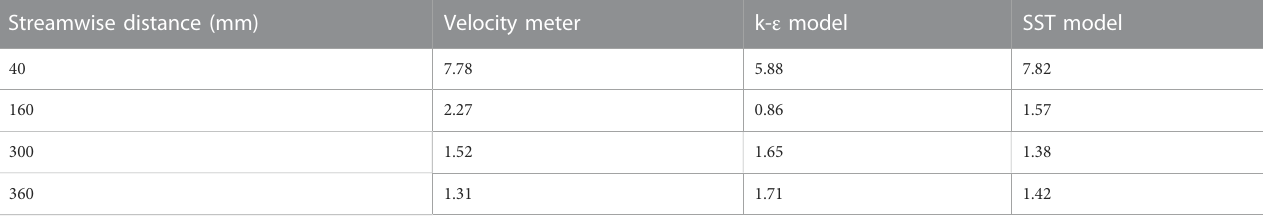
TABLE 1 Air fl ow speed obtained by an air velocity meter and different turbulence model. Unit: